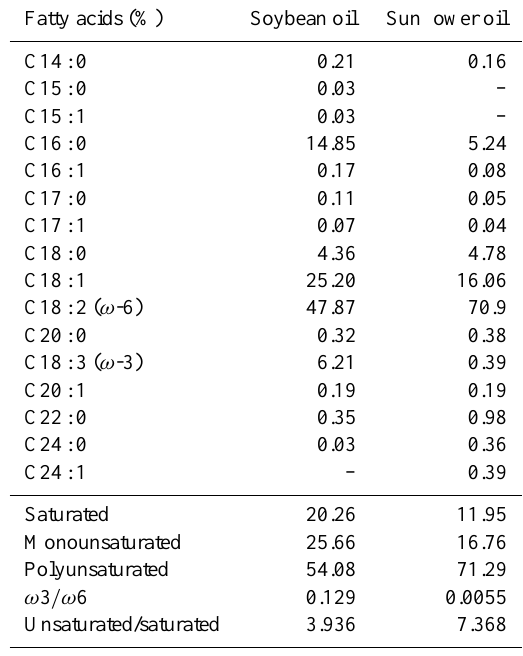
Table 2. Fatty acid composition of soybean and sunflower oils. Fatty acids (%) Soybean